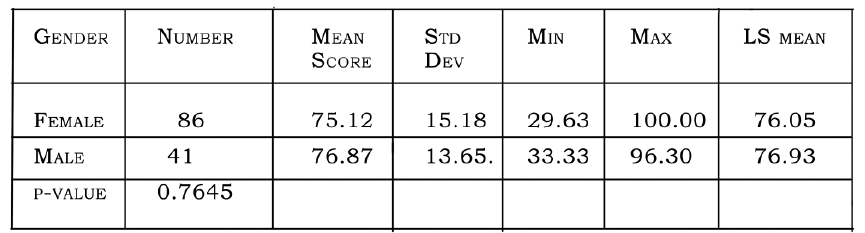
Table 3: Awareness percentage scores by gender: